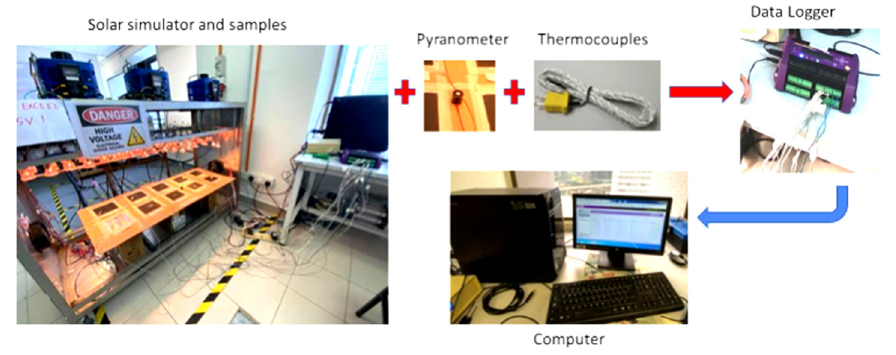
Figure 3. Indoor experimental setup.